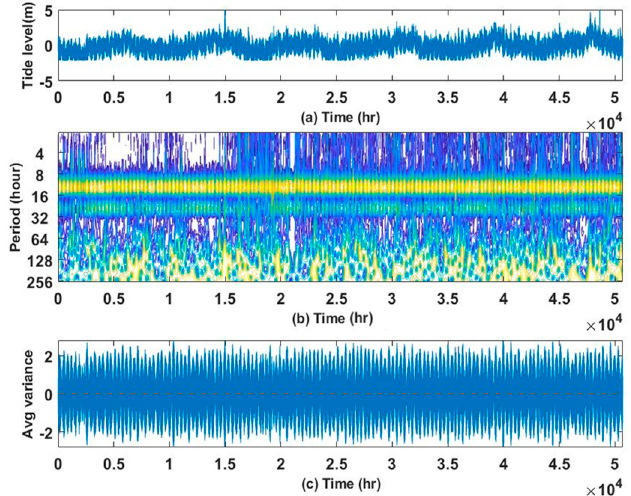
Figure 5. Wavelet analysis result of hourly data: ( a ) Ulsan tide level time series, ( b ) Power spectrum of Ulsan tide level, ( c ) 10–14 h scale-average time series. Yellow lines represent meaningful signal of power spectrum. The 24 h component could not be extracted because this component does not satisfy the 95% confidence level.